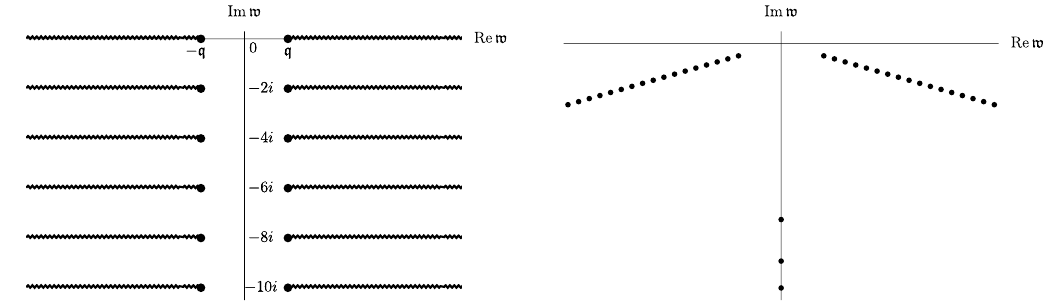
Figure 2 . Singularities of a thermal retarded two-point function G R ( w ; q ) at q 6 = 0 in the complex frequency plane at zero coupling [10] (left panel) and large but (cid:12)nite coupling [18] (right